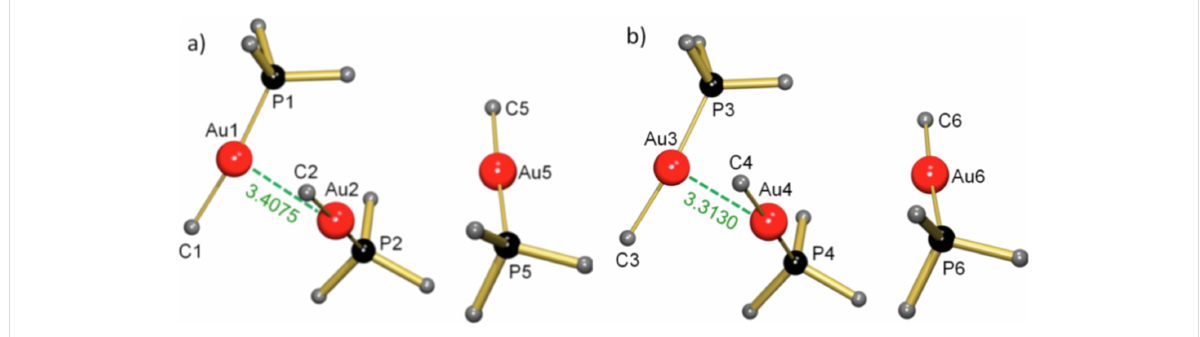
Figure 5: Crystal structure of MeAuPMe 3 . Two groups of three molecules (a, b) have a very similar but not equal packing and differ by a slightly differ- ent orientation.